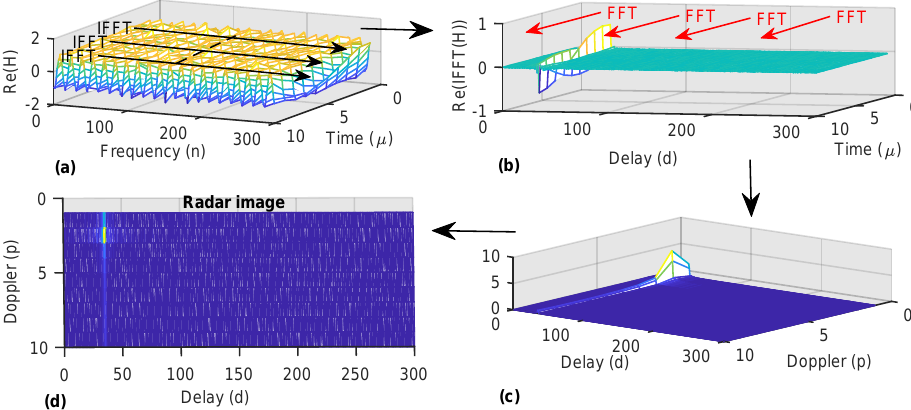
Figure 1. OFDM–based sensing from the channel matrix H . ( a ) IFFT operation over subcarriers. ( b ) FFT operation over OFDM symbols. ( c ) 3–D plot of the delay–Doppler profile. ( d ) Radar image, indicating the delay associated to the range and the Doppler frequency related to the speed of the